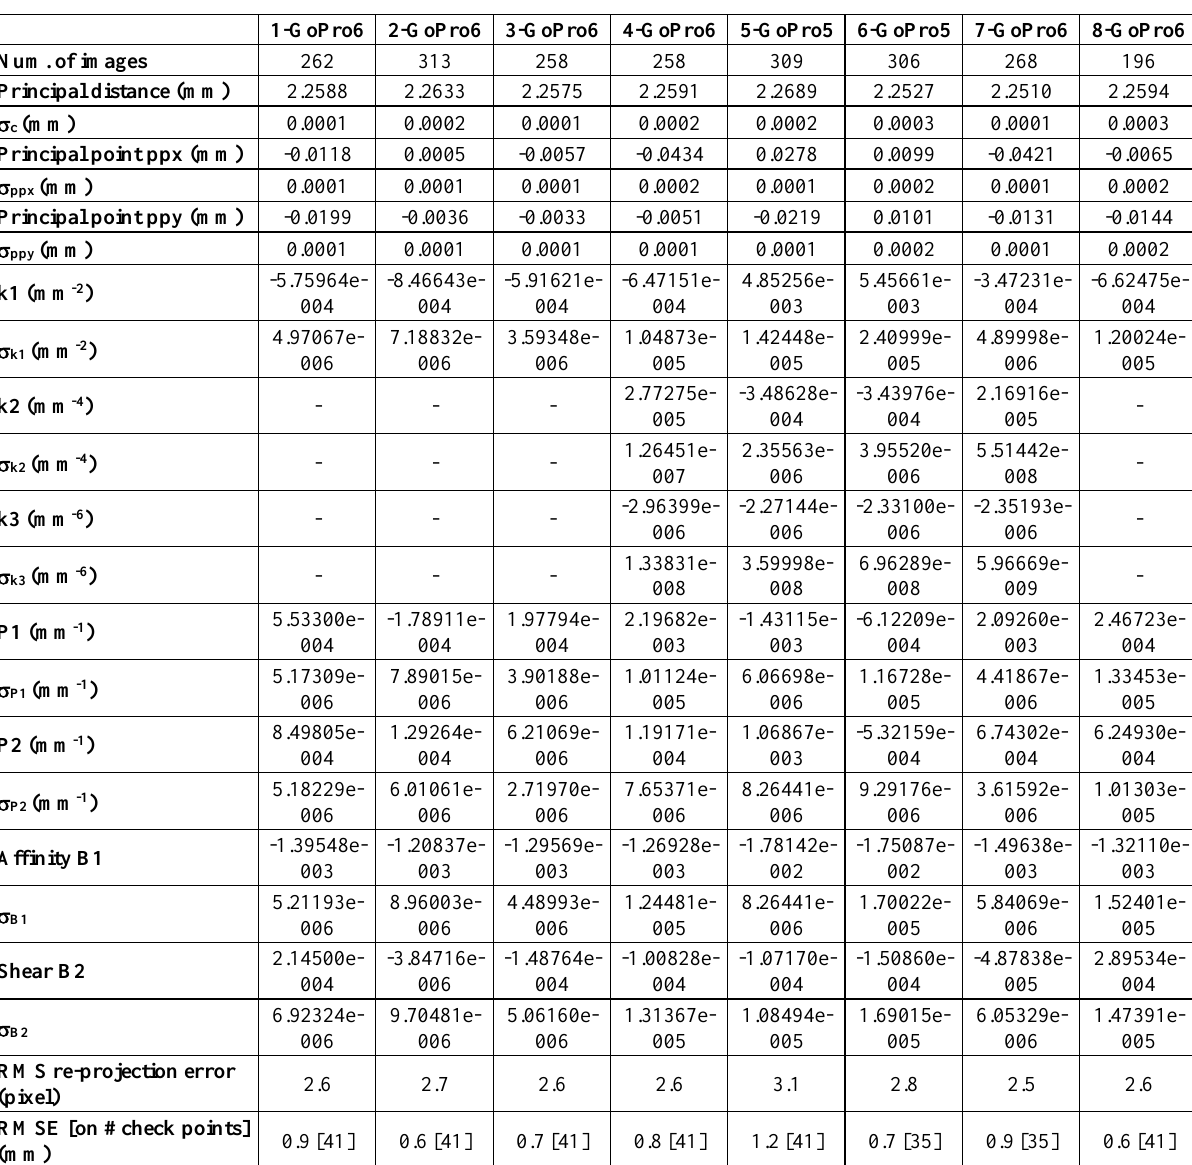
Table 2. Results of self-calibrating bundle adjustment for the eight GoPro cameras. Interior orientation and additional parameters (correction coefficients) are reported along with internal assessment in image (root mean square - RMS of re-projection error) and object space (root mean square error - RMSE on check